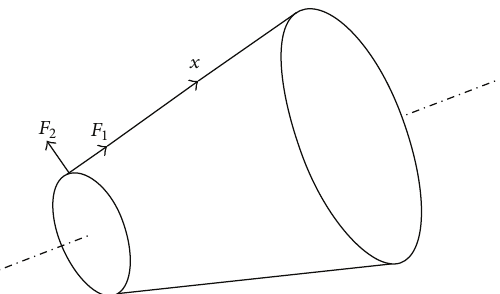
Figure 3: Excitation along the generator and normal to the surface at the smaller end of the conical